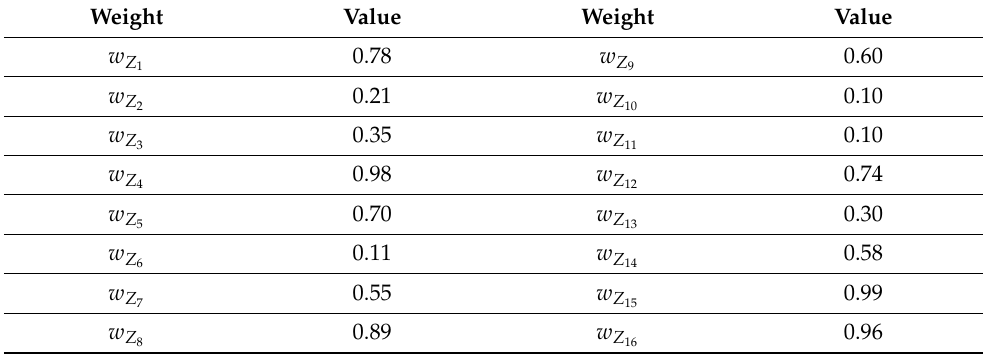
Table 3. Influence degree of each room.